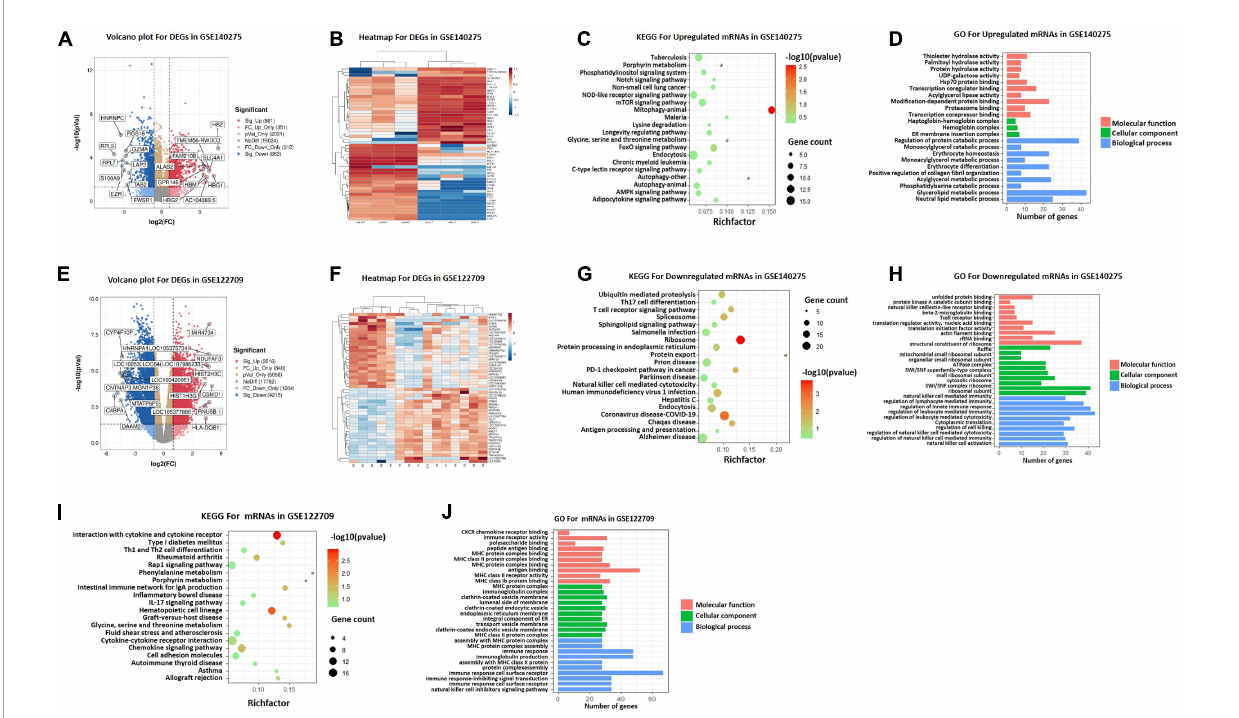
FIGURE2 DEGs screening and functional enrichment analysis. (A) Volcano plot of differentially expressed genes in GSE140275. (B) Heatmap of differentially expressed genes in GSE140275. (C) KEGG pathway analyses of upregulated mRNAs in GSE140275. (D) GO functional analyses of upregulated mRNAs in GSE140275. (E) Volcano plot of differentially expressed genes in GSE122709. (F) Heatmap of differentially expressed genes in GSE122709. (G) KEGG pathway analyses of downregulated mRNAs in GSE140275. (H) GO functional analyses of downregulated mRNAs in GSE140275. (I) KEGG pathway analyses of mRNAs in GSE122709. (J) GO functional analyses of mRNAs in GSE122709. GO, Gene Ontology; KEGG, Kyoto Encyclopedia of Genes and Genomes; DEGs, differentially expressed